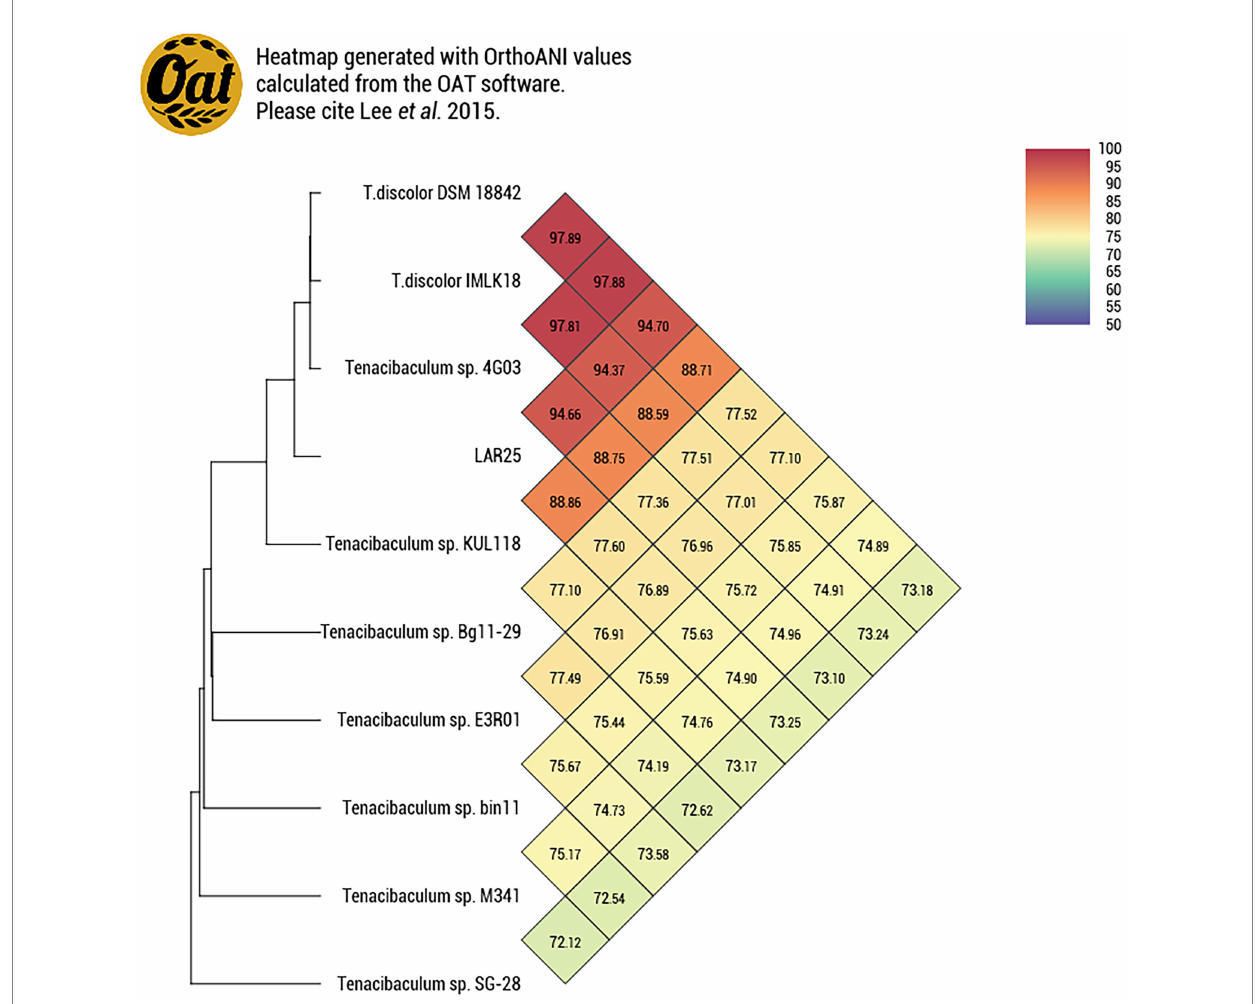
FIGURE 4 Heatmap with OrthoANI values for the LAR25 strain and 9 genomes of Tenacibaculum spp. [Heatmap generated with OrthoANI values calculated from the Orthologous Average Nucleotide Identity Tool (OAT)